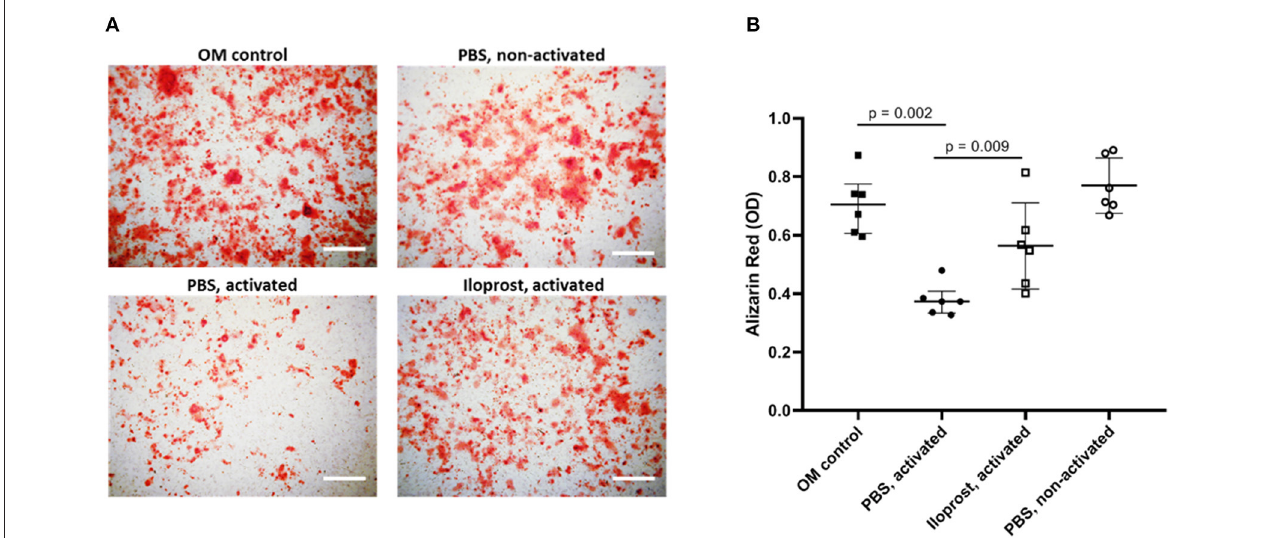
FIGURE 7 | Osteoimmunological effect of Iloprost treated bone marrow cells. α -CD3/ α -CD28 activated bone marrow cells were cultured either with Iloprost or PBS as control. Obtained conditioned media was added to an osteogenic differentiation culture of MSCs and the secretion of mineralized matrix was measured by Alizarin Red staining. (A) Representative images of the Alizarin Red staining of the different culture conditions. (B) Quantification of the Alizarin Red signal. OM, osteoinductive media. Scale bars: 200 µ m; n = 6.